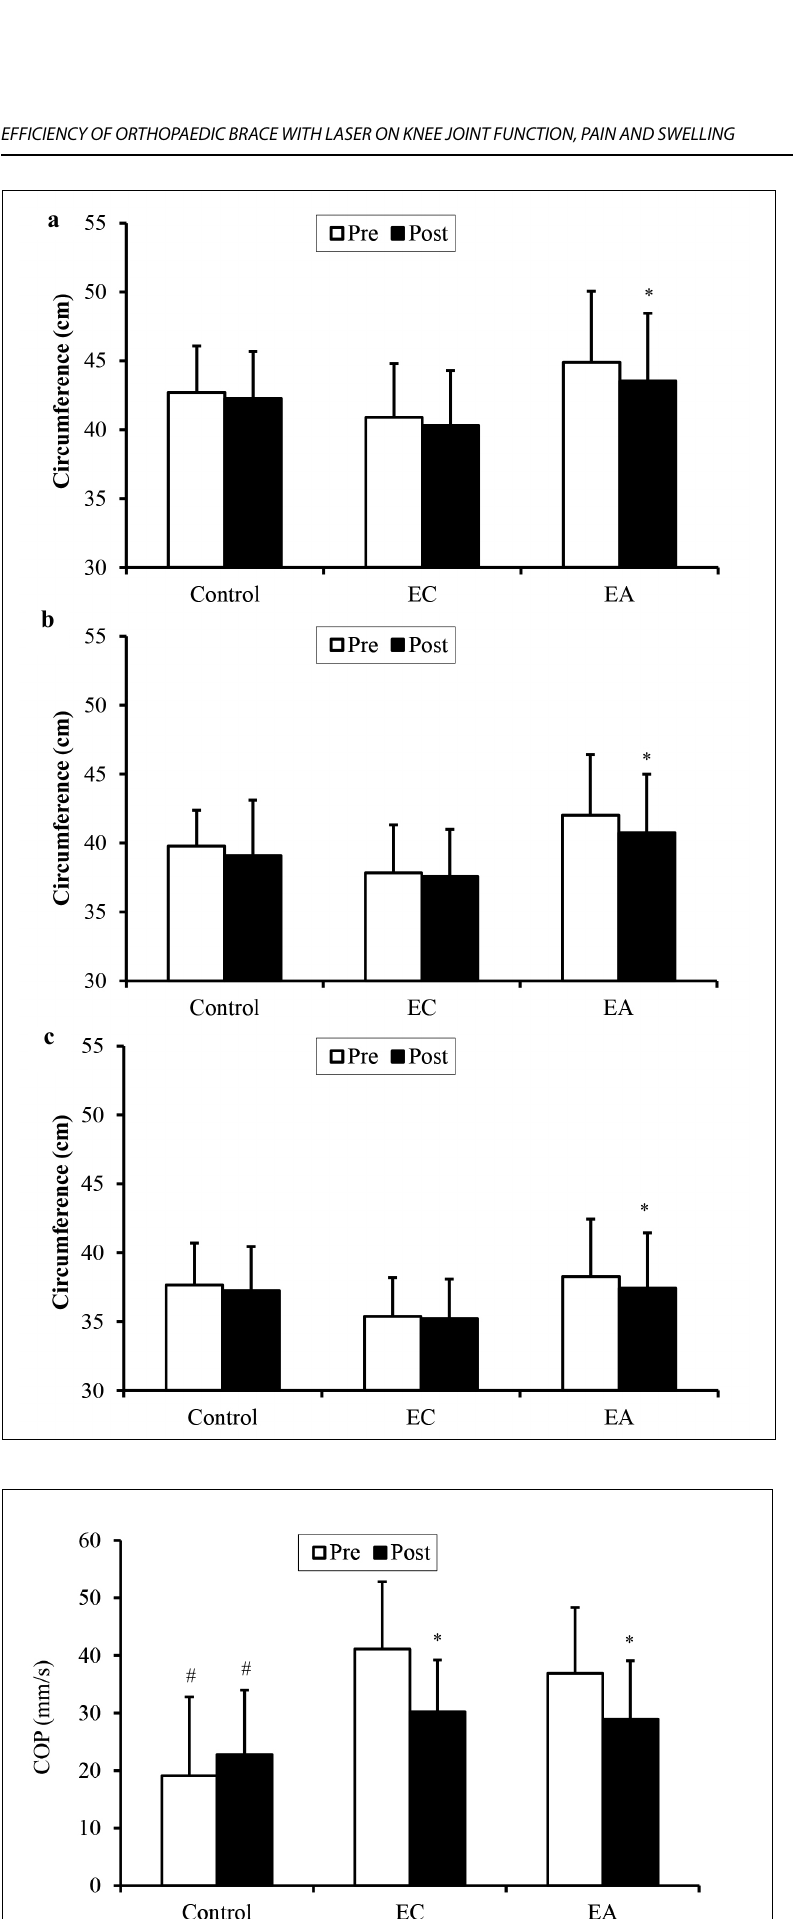
Note. * p < .05 comparing to pre intervention value, # p <.05 compared with EC and EA